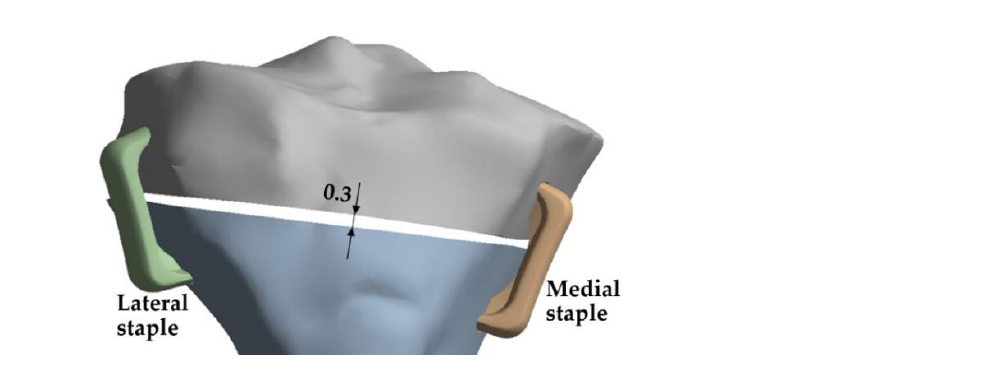
Figure 15. The total displacement of staples (mm), deformed + undeformed shape, deformation scale 10:1.